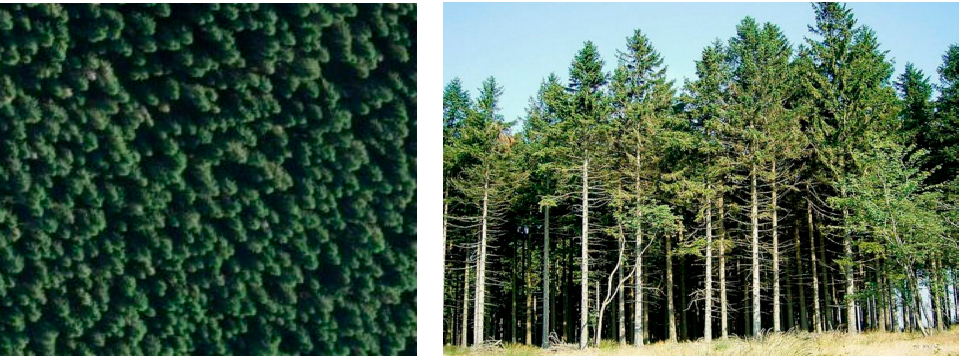
Figure A1. Aerial photo and photo of class A1.